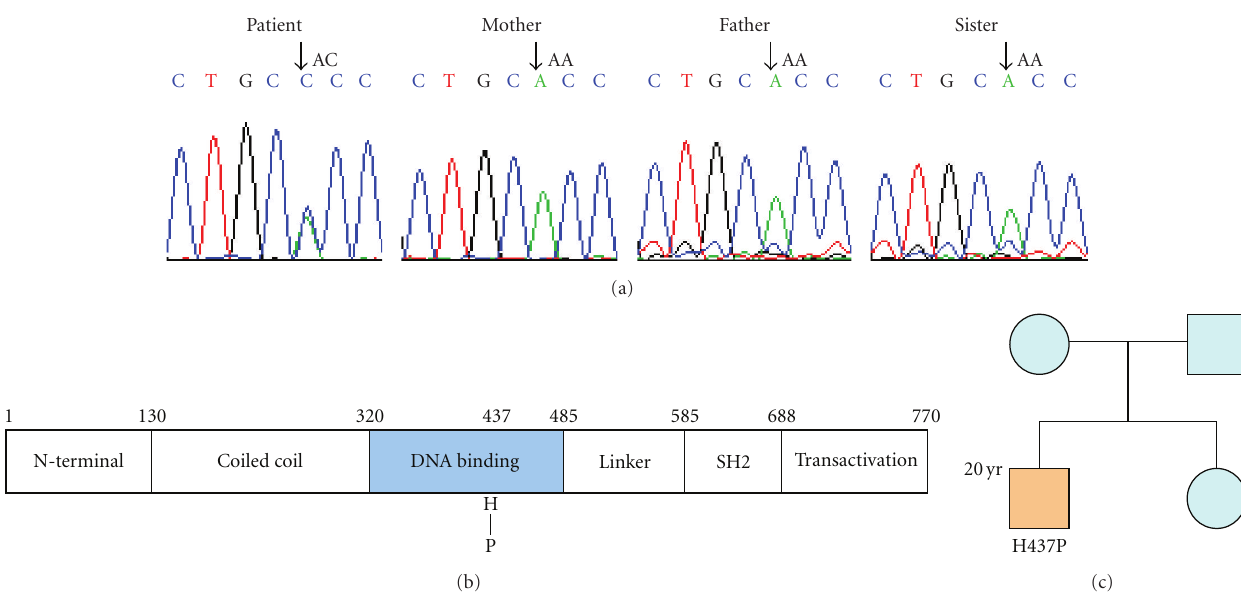
Figure 2: Sequencing results of STAT3 cDNA. (a) Heterozygous mutation in STAT3 genomic sequence of the patient. (b) Schematic of STAT3 amino acid structure and the identified mutation, H437P (1310A → C) in the DNA binding domain. (c) Pedigree of this family a ff ected by the Hyper-IgE syndrome, the mutation was de novo, not inheritance.